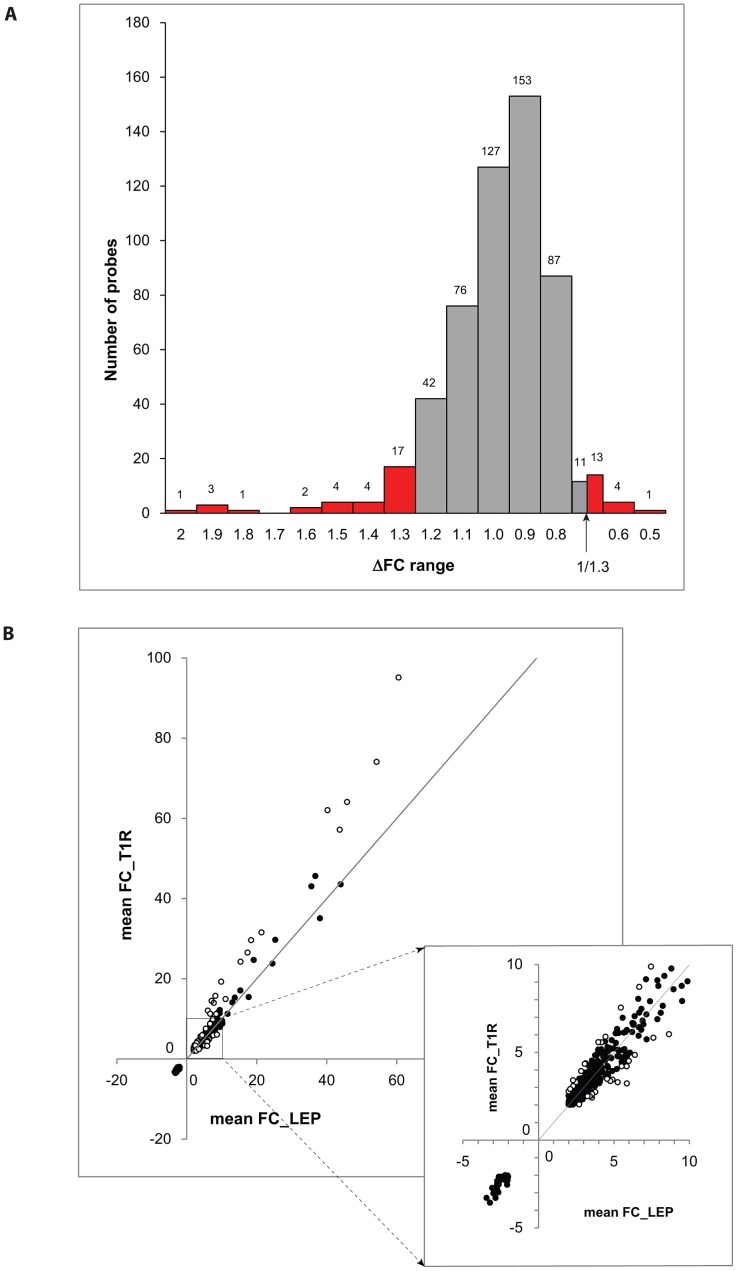
Differentially triggered genes by M. leprae sonicate in whole blood of T1R-affected and T1R-free leprosy patients.
A: The distribution of ΔFC values of 532 gene probes (corresponding to 462 genes) that were induced by M. leprae antigen with |FC|≥2. Probes outside the cut-off values of ΔFC≥1.3 and ΔFC≤1/1.3 are indicated in red. These 50 probes which represent the extreme decile (9.4%) of the ΔFC values tagged 44 genes. These 44 genes are the T1R-specific gene set. B: Mean fold changes of the 532 |FC|≥2 gene probes for T1R-free leprosy patients (mean FC_LEP) plotted against the mean fold changes of the same probes for T1R-affected leprosy patients (mean FC_T1R). Each dot represents a single gene. Open circles represent the T1R gene set. The insert displays genes with mean FC of −5 to +10.